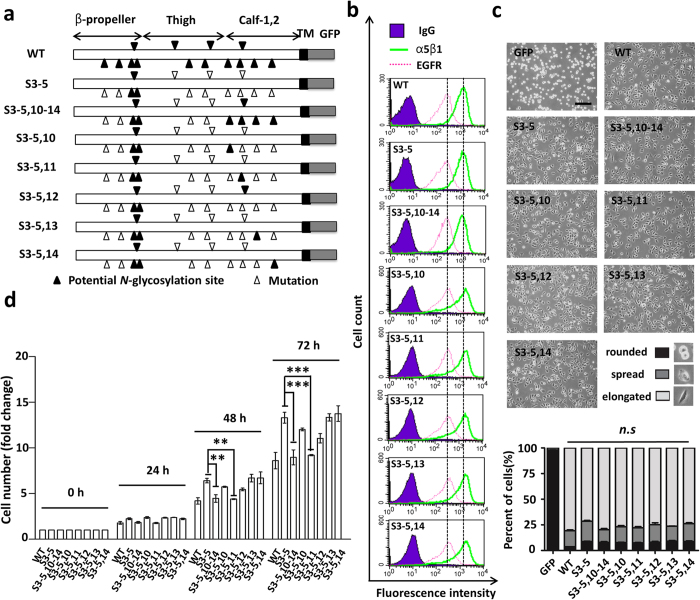
Effects of various unglycosylated mutant α5 subunits expression on cell growth in CHO-B2/EGFR cells.(a) Schematic diagram of potential N-glycosylation sites on the WT and mutational integrin α5 subunits (WT; S3–5; S3–5,10–14; S3–5,10; S3–5,11; S3–5,12; S3–5,13 and, S3–5,14). Putative N-glycosylation sites (N84Q, N182Q, N297Q, N307Q, N316Q, N524Q, N530Q, N593Q, N609Q, N675Q, N712Q, N724Q, N773Q, and N868Q) are indicated by solid triangles, and point mutations are indicated by hollow triangles. (b) The integrin α5 mutant cells expressed equal α5β1 and EGFR levels on the cell surface, compared with the WT cells. The stable cell lines were established as described under the “Methods” section. The expression levels of both α5β1 and EGFR were analyzed by flow cytometry. The IgG was used as a control. (c) The α5 mutant cells exhibited abilities for cell spreading that were comparable to those of WT. Cells were detached and then replated on the FN-coated dishes. After incubation for 20 min, cells were fixed and the representative images were taken. The percentages of rounded, spread, and elongated cells were statistically analyzed (right bottom panel, n = 9). Scale bar, 120 μm. (d) The S3–5,11 cells exhibited inhibitory ability for cell growth that was comparable to that of the S3–5,10–14 versions. After starvation for 24 h, cells were supplied with DMEM containing 10% FBS, and then cell numbers were counted and statistically analyzed at indicated times (n = 3 individual experiments). All values are reported as the means ± S.E. (error bars), Student’s t-test; n.s, not significant (p > 0.05); **p < 0.01; ***p < 0.001.